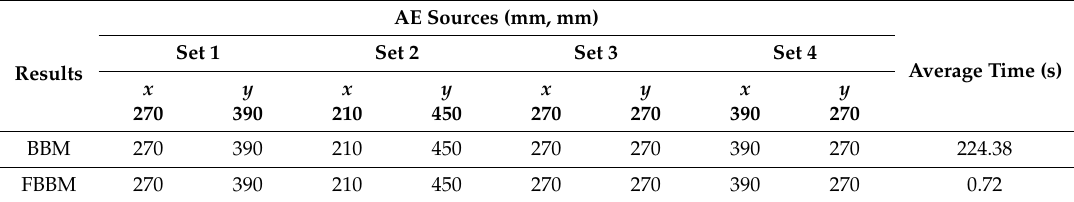
Table 2. It can be seen from Table 2 that the calculation speed of the fast Bartlett beamforming method (FBBM) is significantly higher than that of BBM while maintaining the same positioning accuracy. Table 2. Localization comparison of the BBM and the FBBM at v = 5300 m/s.